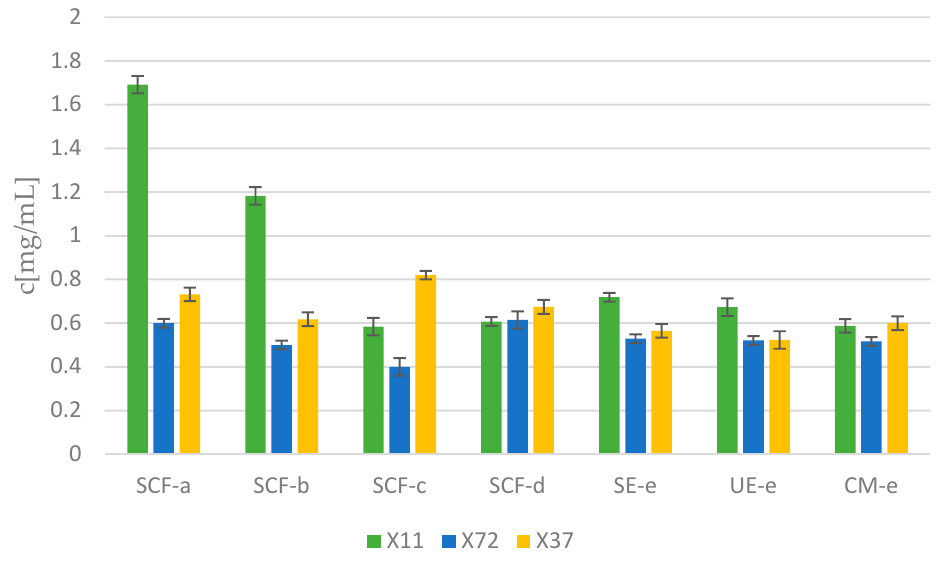
Figure 3. Concentration at which the metabolic activity of a melanoma cell is equal to 50% (IC50).